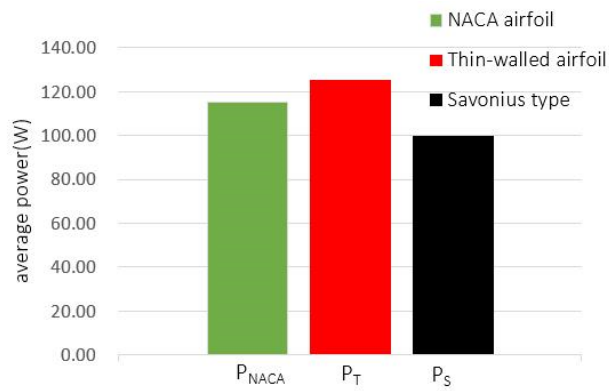
Energies 2020 , 13 , x FOR PEER REVIEW Figure 8. Maximum power and time ratio at each flow rate. Figure 8. Maximum power and time ratio at each flow rate.